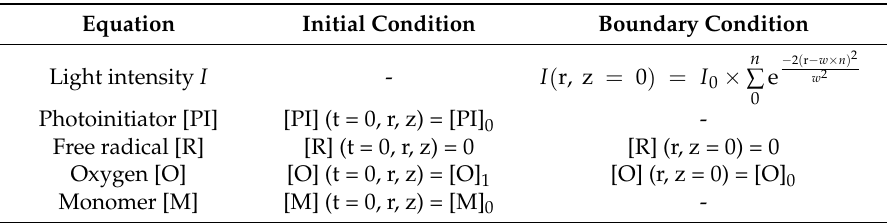
Table 1. Initial and boundary